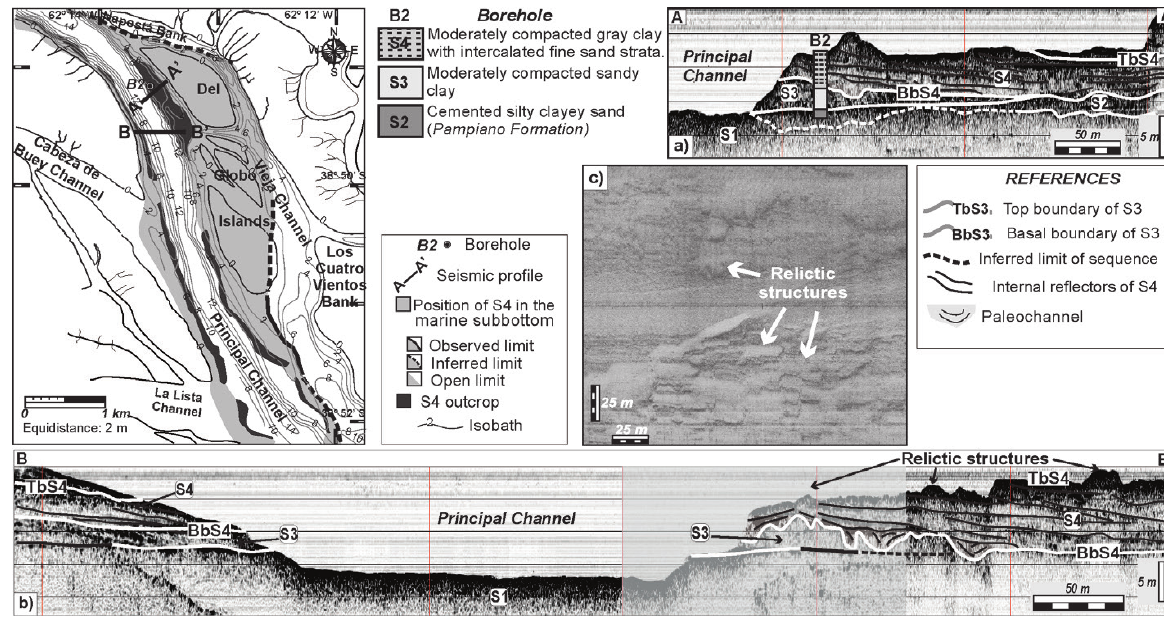
Fig. 4 - Seismic sequence S4. A-A` and B-B`: 3.5-kHz profiles showing stratigraphic features. C: side scan sonar record. Areal distribution of S4 in the marine subbottom and lithological data